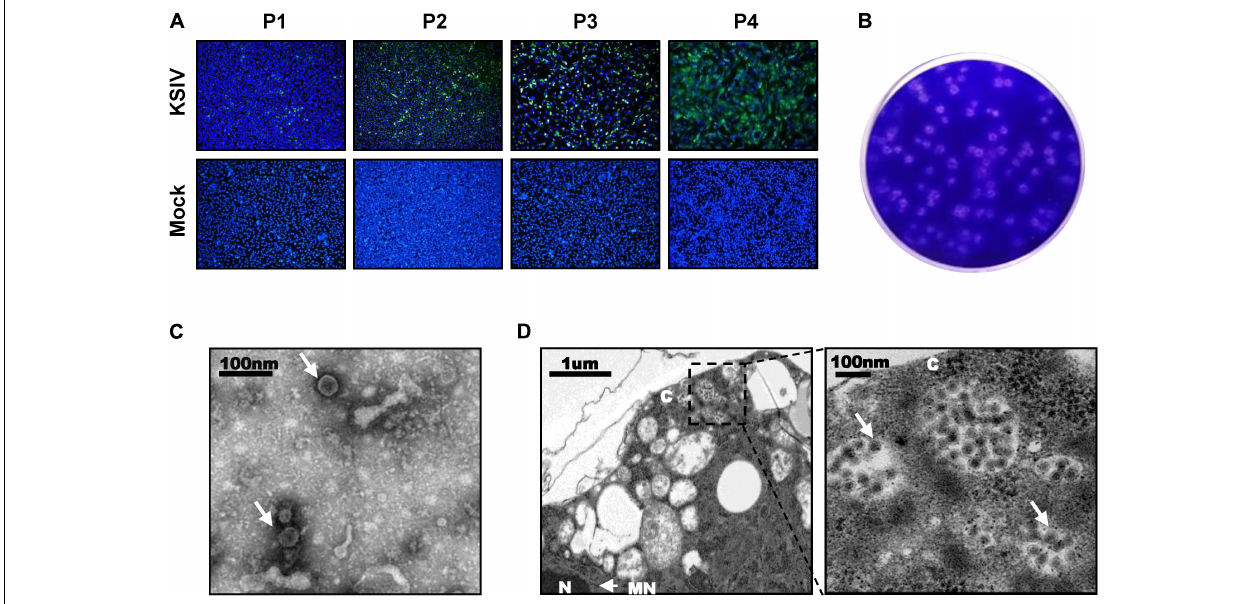
FIGURE 1 | Karshi virus (KSIV) isolation, characteristics and analysis of viral particles. (A) Immunofluorescence assays to survey KSIV isolation in BHK-21 cells. The images were taken from different passages showing KSIV proliferation. Cells were immunostained and green fluorescence indicates the cells infected by KSIV. P1, the first passage; P2, the second passage; P3, the third passage; P4, the fourth passage. (B) Plaque assay to verify KSIV isolation in BHK-21 cells with the P4 supernatants. Cells were stained with crystal violet to show plaques at 3 days post-infection. (C) TEM analysis of KSIV particles purified from supernatants harvested from BHK-21 cells infected with KSIV at 3 days post-infection. The clarified supernatants were subjected to ultracentrifugation. The fractions containing viral particles were harvested and used in negative-staining. (D) The image obtained by TEM shows that virus particles were located in the cytoplasm of infected BHK-21 cells. The enlarged area on the right shows groups of virus particles (arrow). N, nucleus; C, cytoplasm; NM, nuclear